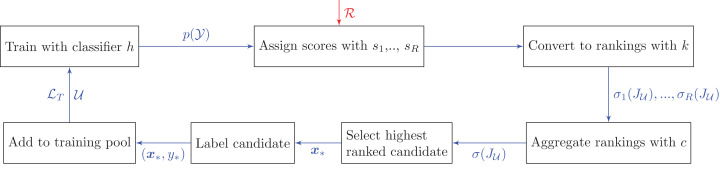
Active learning pipeline with rank aggregation methods.Unlike the bandit pipeline, there is only one cycle in which we aggregate information from all heuristics. Additional notation: \documentclass[12pt]{minimal}
\usepackage{amsmath}
\usepackage{wasysym}
\usepackage{amsfonts}
\usepackage{amssymb}
\usepackage{amsbsy}
\usepackage{upgreek}
\usepackage{mathrsfs}
\setlength{\oddsidemargin}{-69pt}
\begin{document}
}{}${\rm{\sigma }}({J_{\cal U}})$\end{document}σ(JU) is a permutation (i.e., rank) on the index set of the unlabeled data.